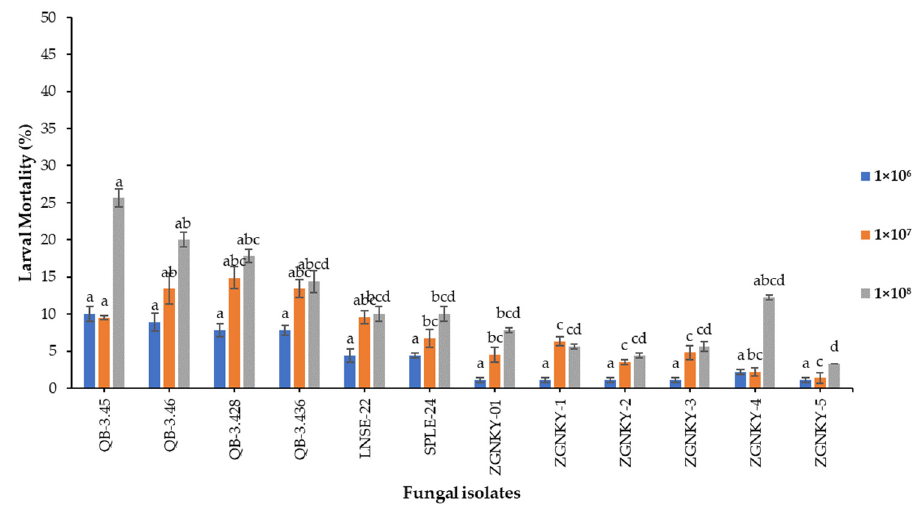
Figure 3. Mortality of second instar larvae of FAW infected with different concentrations of B. bassiana isolates. Means followed by the same letters of alphabets are not significantly different according to Tukey’s test at p < 0.05.